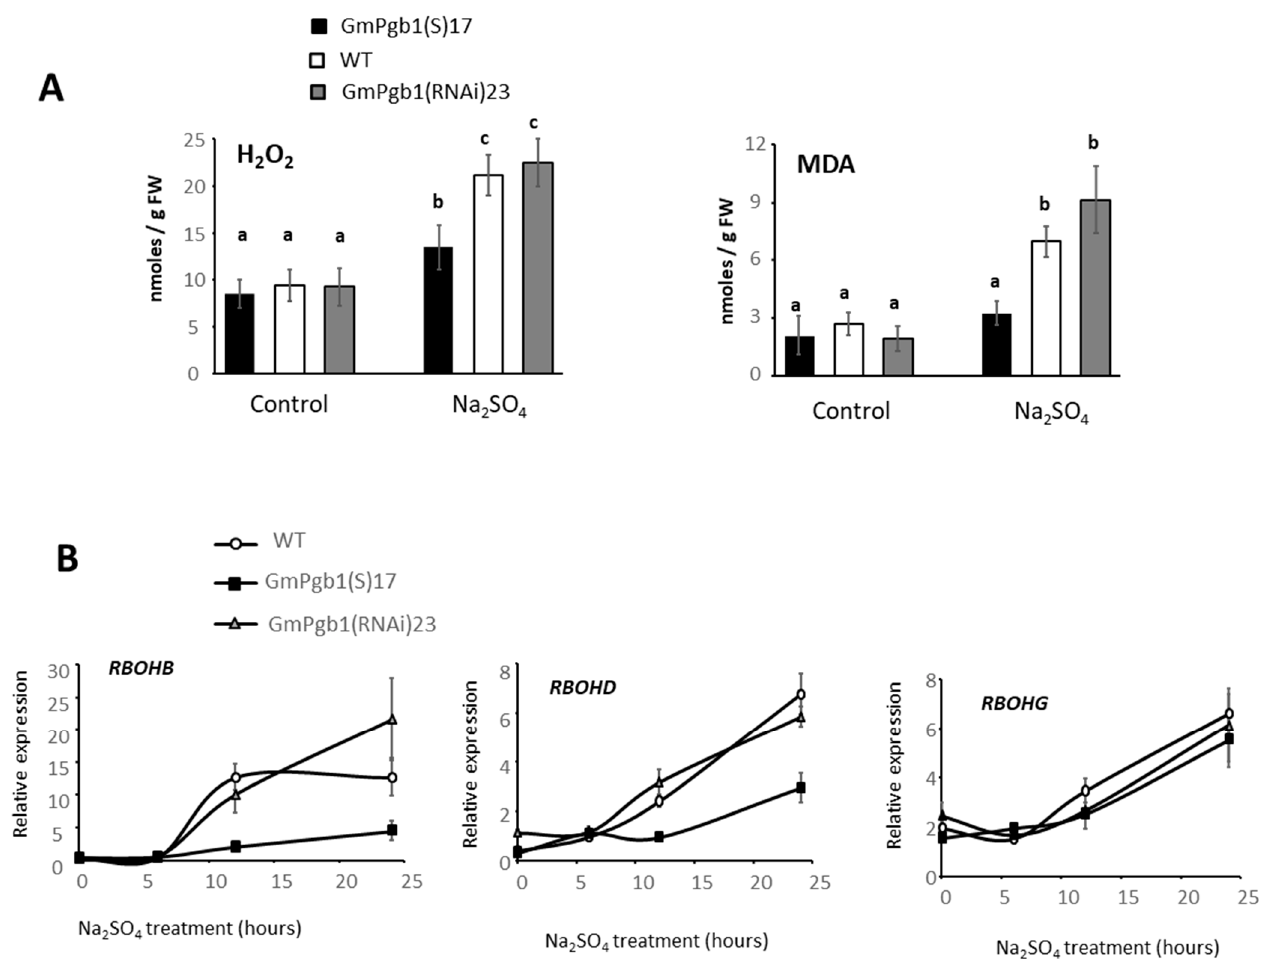
Figure 5. ROS and ROS-induced damage in leaves of soybean plants exposed to Na 2 SO 4 . ( A ) Level of H 2 O 2 and malondialdehyde (MDA) in leaves of WT plants and plants overexpressing (GmPgb1(S)17) or downregulating (GmPgb1(RNAi)23) GmPgb1 . Values are the means ± SE of three biological replicates, each consisting of at least three plants. Letters indicate statistically significant differences ( p < 0.05). ( B ) Relative expression levels of respiratory burst oxidase homologs (RBOHB, D and G) in leaves of plants indicated in ( A ). Values are means ± SE of three biological replicates, each consisting of at least three plants.